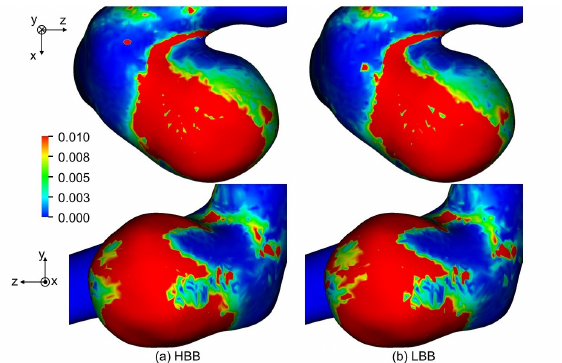
Figure 15. Comparison of OSI between ( a ) HBB and ( b ) LBB (the spatial resolution: N x =